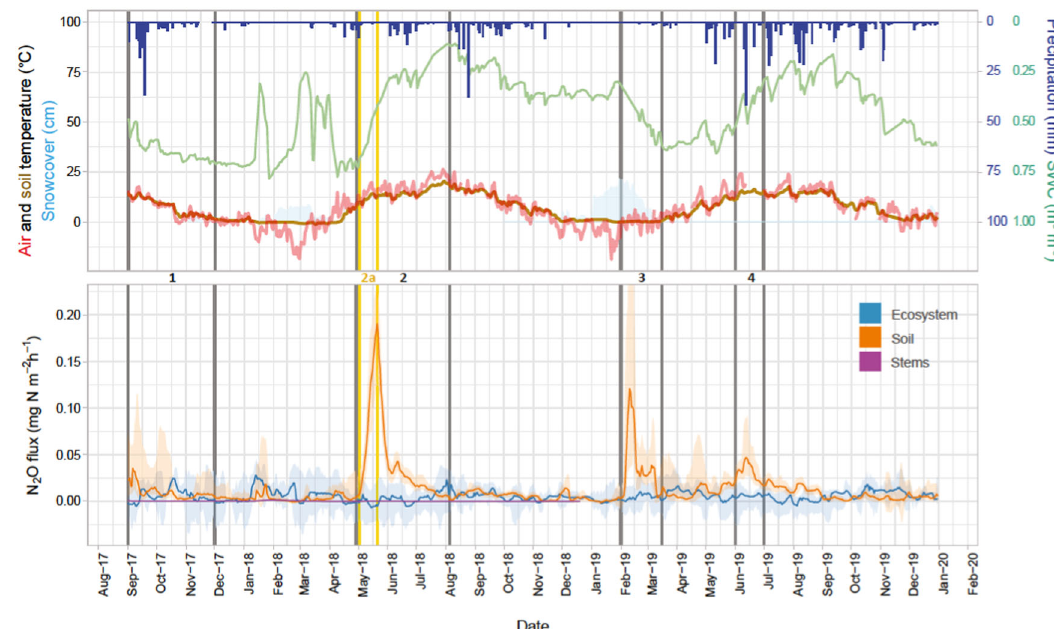
Fig. 1 Dynamics of ecosystem-level N 2 O fl uxes in the Agali gray alder forest during the study period Sep 2017 – Dec 2019. Lines are 5-day median values and shaded areas are 25th and 75th percentiles. Vertical lines show the beginning and end of hot moments: 1 = Wet (2017-09- 01 … 2017-12-01), 2 = Dry (2018-05-01 … 2018-08-05) with 2a = Drought Onset (2018-05-02 … 2018-05-21), 3 = freeze-thaw (2019-02-01 … 2019-03-15), and 4 = Dry-Minor (2019-06-01 … 2019-06-30). The air temperature was measured at 50 cm from the soil surface representing the near-ground air temperature. Note that the origins are on opposite ends of the left- and right-side